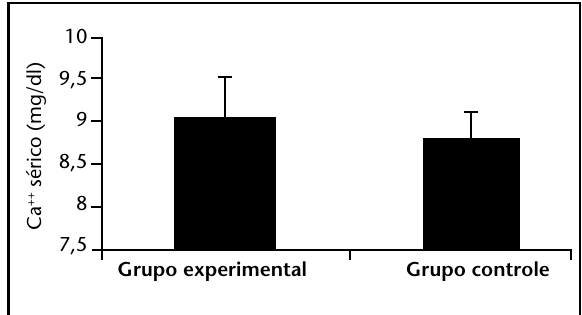
Figura 4 – Dosagens séricas de cálcio nos grupos experimental e controle